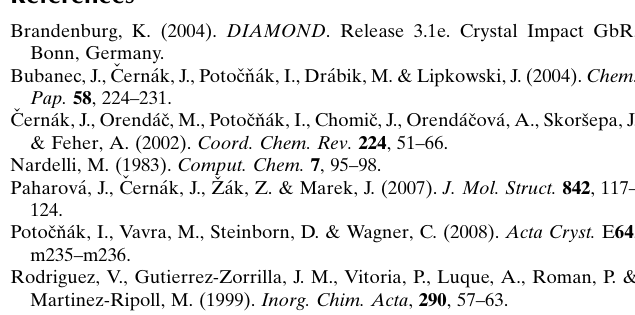
Stoe IPDS diffractometer Absorption correction: Gaussian